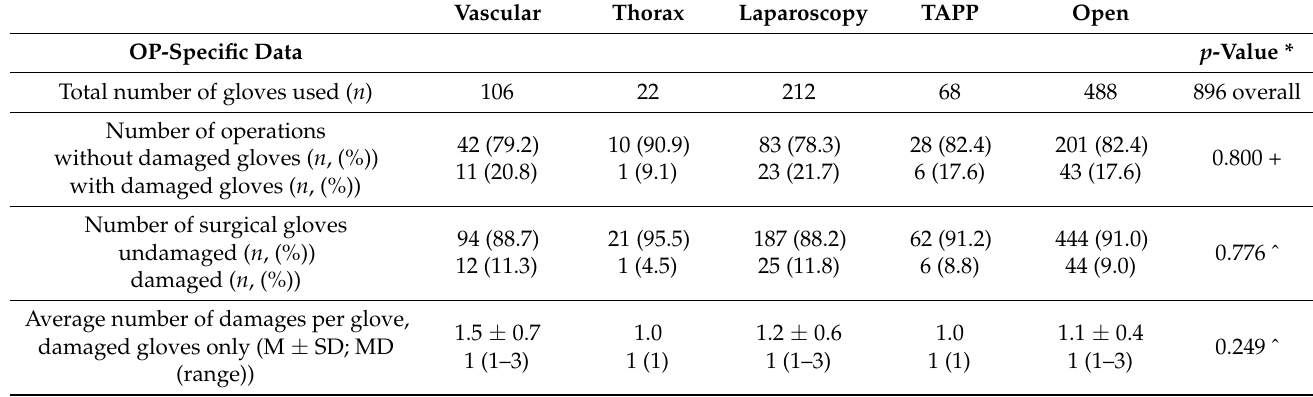
Table 3. Statistical analysis of surgical data with regard to the occurrence of glove damage of the entire surgery. (*) Total